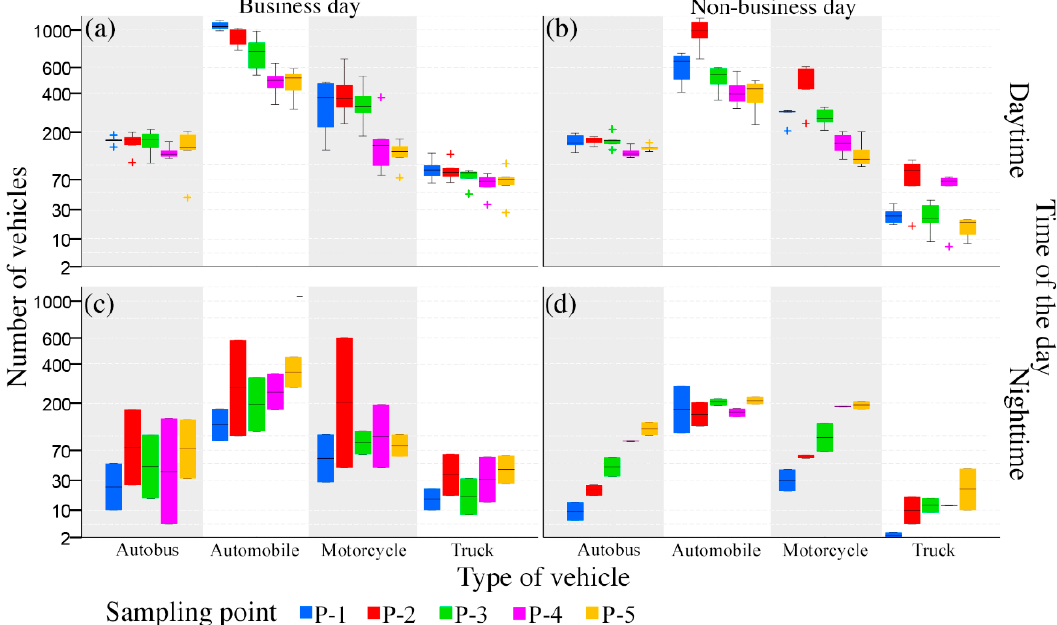
Figure 3. Quantity of vehicle types recorded per day of the week, time of day, and sampling point (P: point). ( a ) Weekday, daytime. ( b ) Weekend, daytime. ( c ) Weekday, night-time. ( d ) Weekend, night-time.